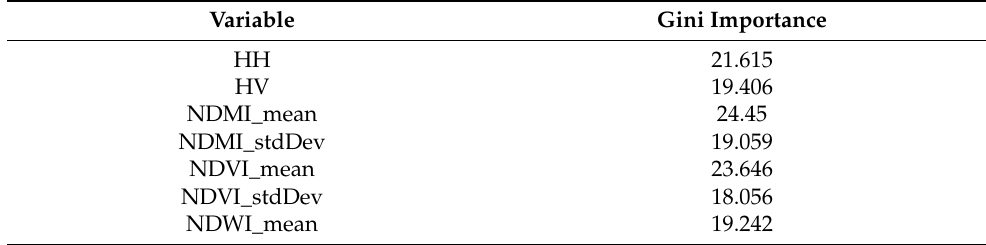
Table 7. Relative importance of the variables for the model classifying intact and not-intact pixels for Rakhine